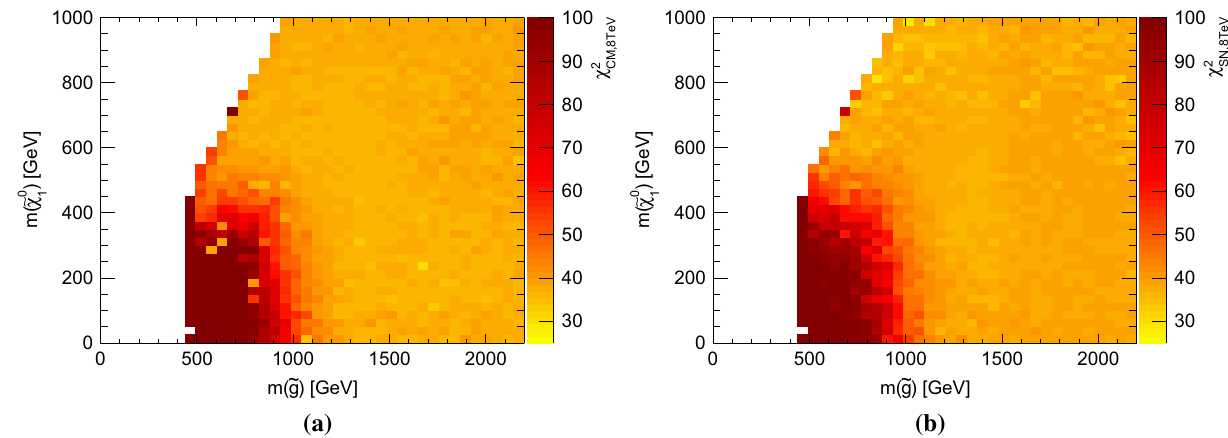
Fig. 7 MinimumpMSSM-11 χ 2 inthegluino–neutralinomassplaneforthe8TeVvalidationsetfortheCheckMATEresults( a )andthepredictions of SCYNet ( b )